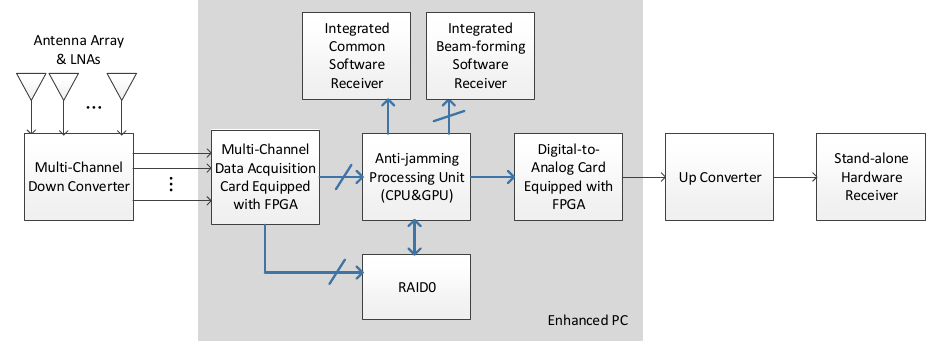
Figure 1. System architecture and data flow path of the adaptive array anti-jamming testbed. The thin black lines and arrows indicate the analog signal stream, while the bold blue lines and arrows indicate the digital data stream. The short slashes upon the lines indicate that the stream contains multiple channels.